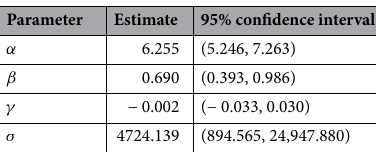
Table 6. Maximum likelihood estimates and 95% confidence intervals for the model with IgG S2 + NP.